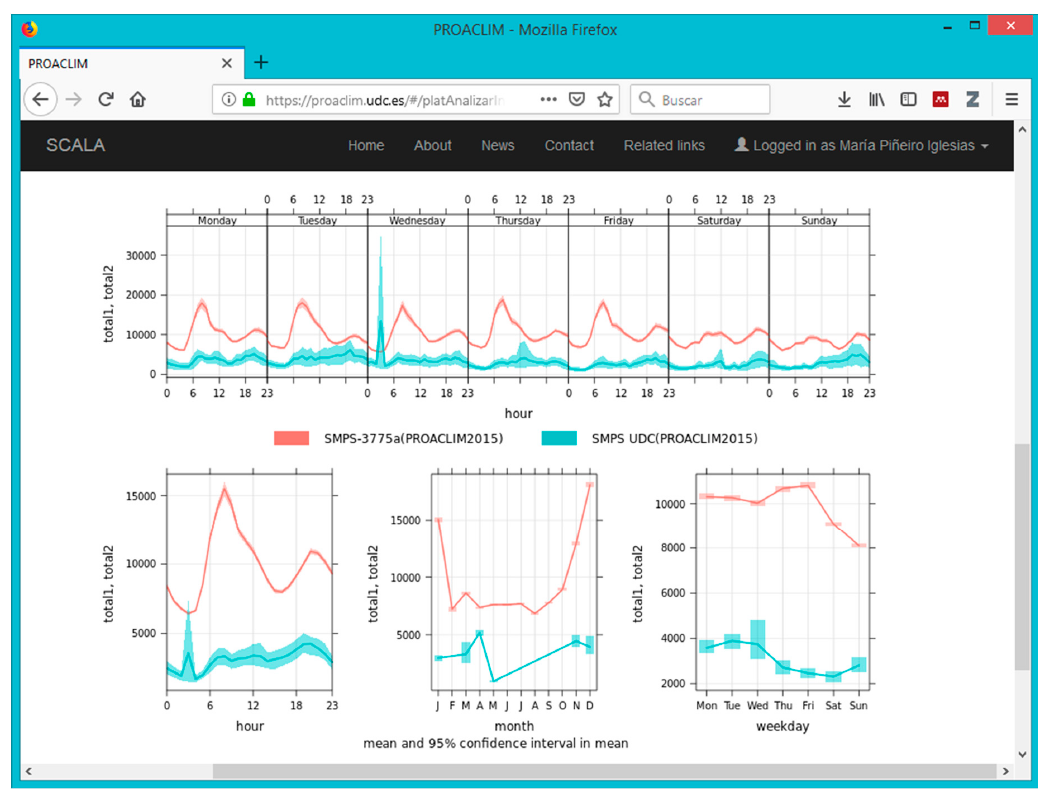
Figure 8. Total particle number concentration (cm − 3 ) vs. time (UTC hour, month and day) for the year 2015 at CIEMAT (total1) and UDC (total2) sites.